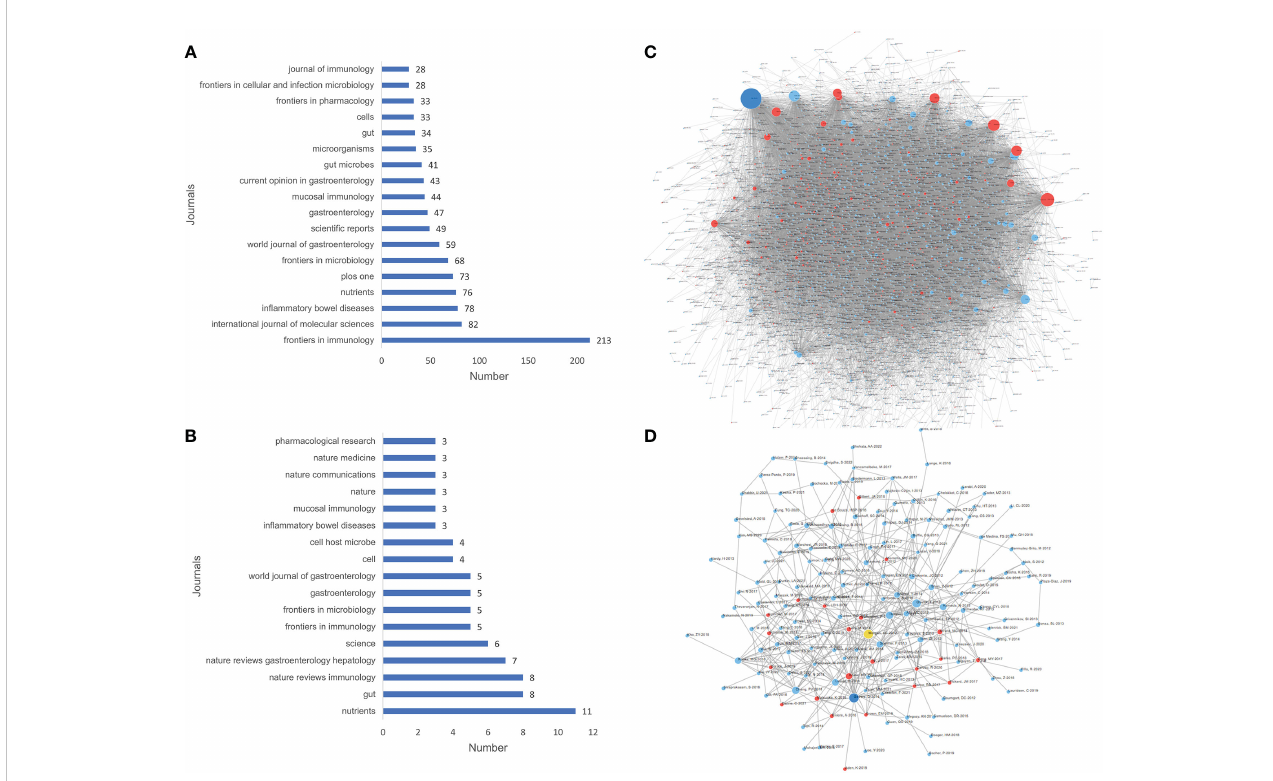
FIGURE 5 The number of articles published by journals (A, B) and the article citation relationship network (C, D) of relevant literature. ( A, C : all relevant literature; B, D : citation classics; C, D: Each small blue dot represents an article, the links represent citations, and the larger the blue dot, the more citations. The dark blue dot is the most cited article, and the red dots are the articles that cite that